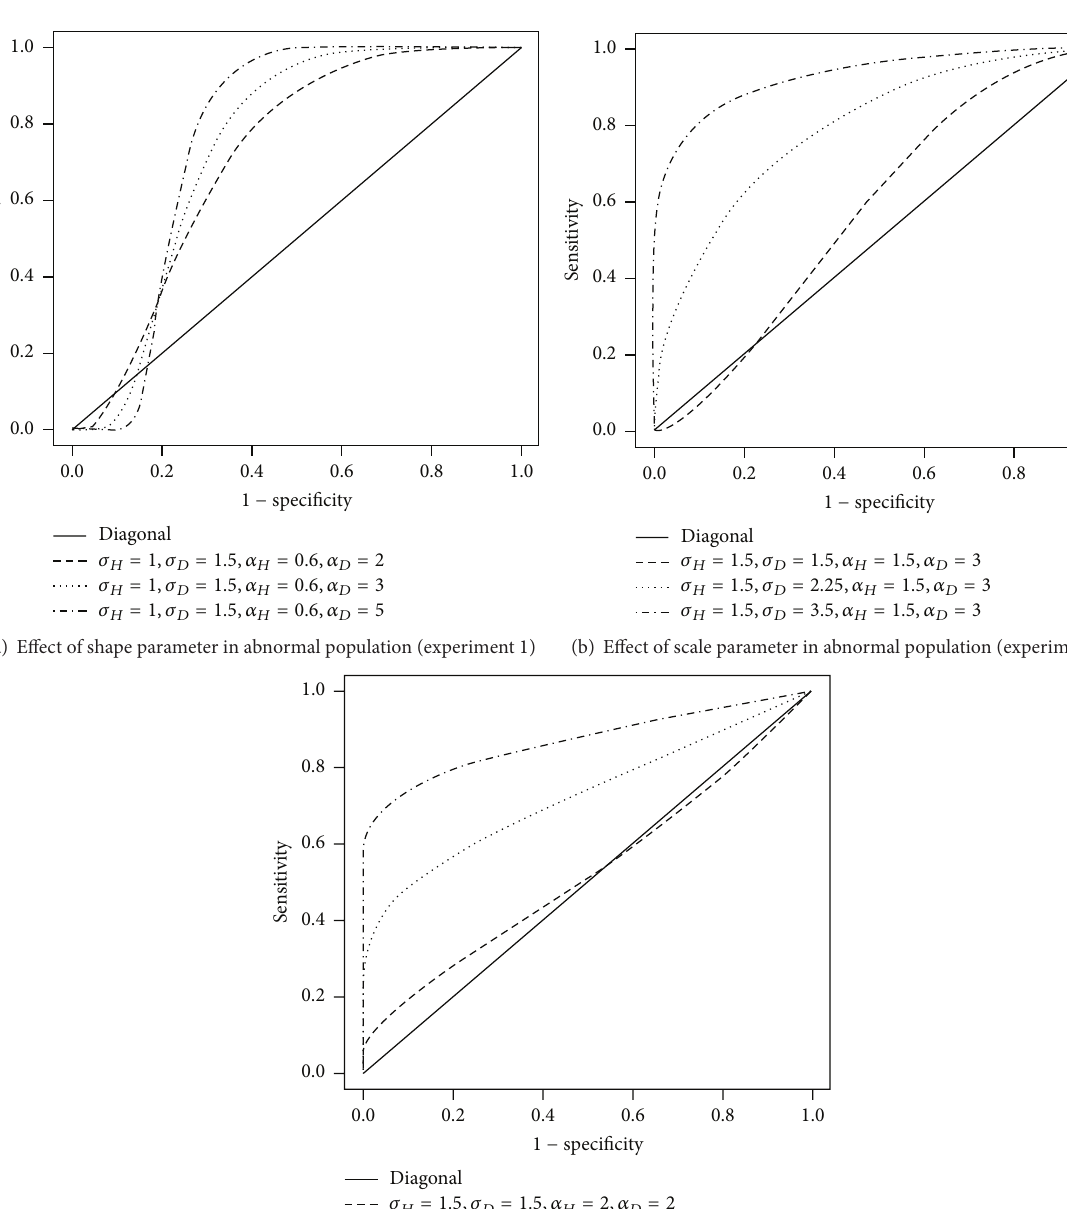
all the combinations which are defined as three different